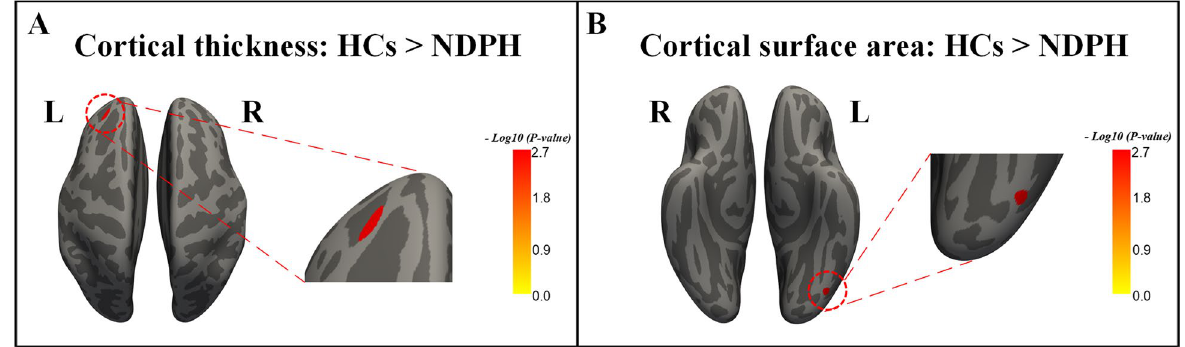
Fig. 2 The abnormal cortical thickness and surface area in NDPH. A The NDPH group showed significantly decreased cortical thickness in the left rostral middle frontal gyrus compared with HCs. B The NDPH group showed significantly decreased cortical surface area in the left fusiform gyrus compared with HCs. HCs, healthy controls; NDPH, new daily persistent headache; L Left; R Right